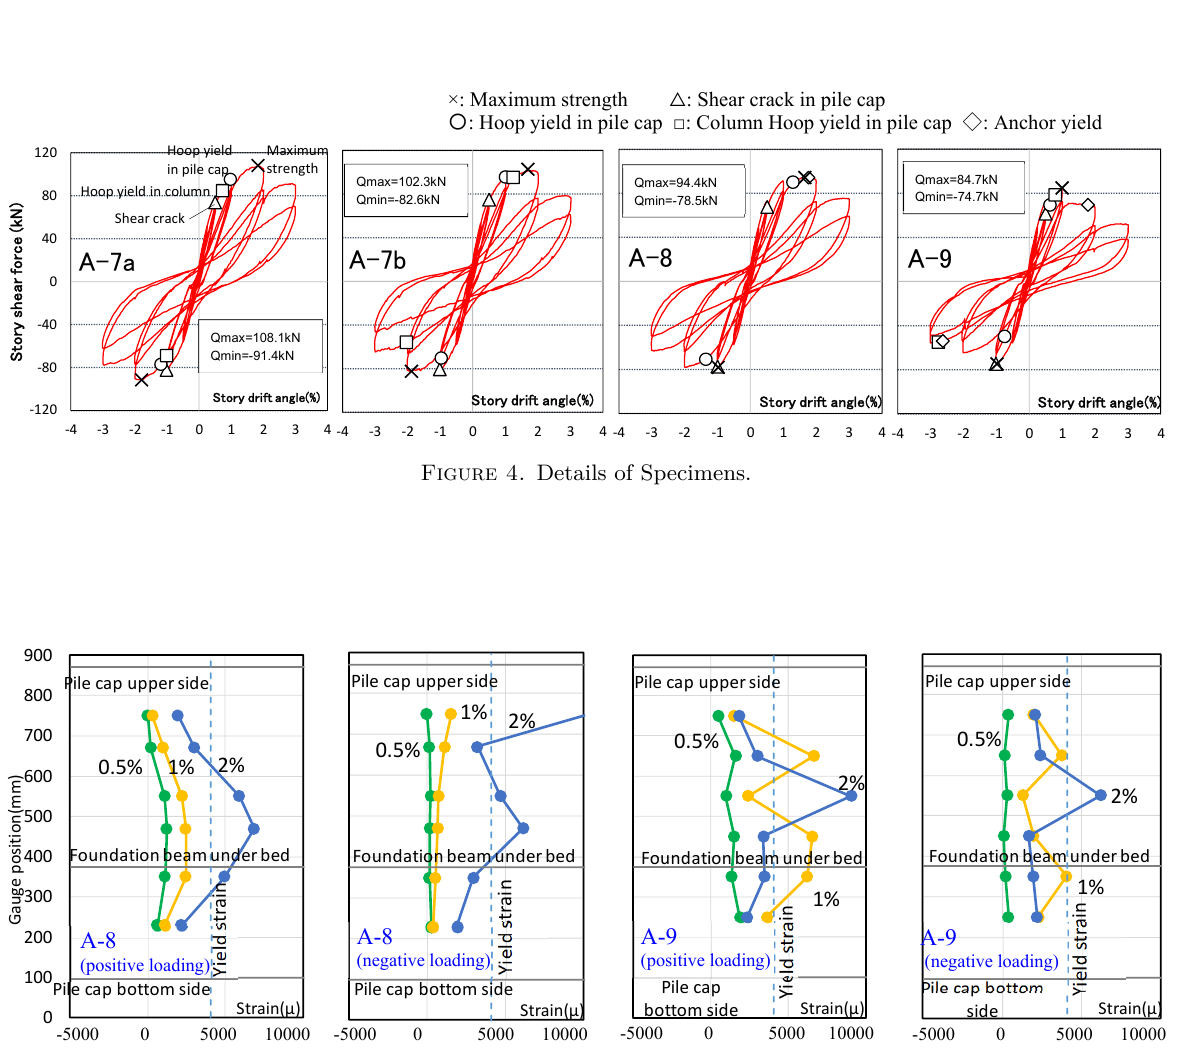
Figure 5. Strain distribution of pile cap